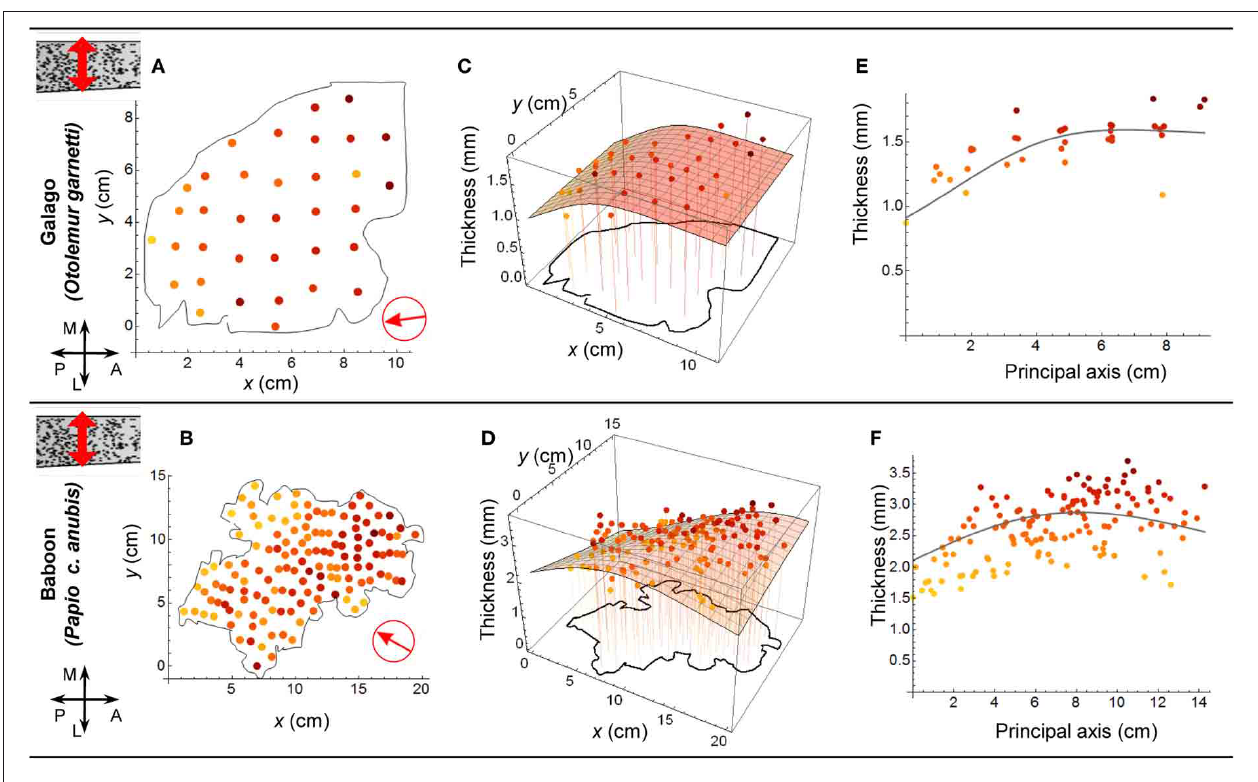
FIGURE 4 | Cortical Thickness. Sample average thickness of cortex as calculated by dividing the number of neurons per column by the density of neurons for each sample in the study by Collins et al. Cortical thickness is seen to, on average, be reduced in posterior regions. The surfaces